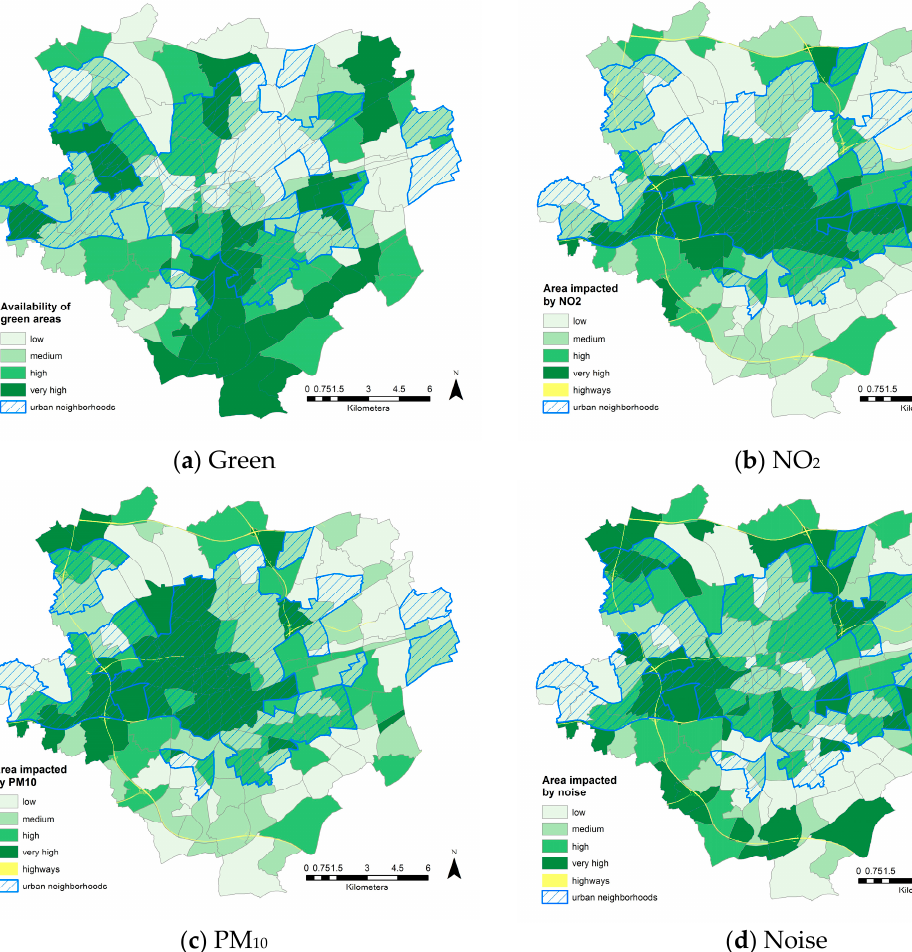
Figure 3. Maps of the four environmental indicators: ( a ) proportion of green areas per neighborhood;